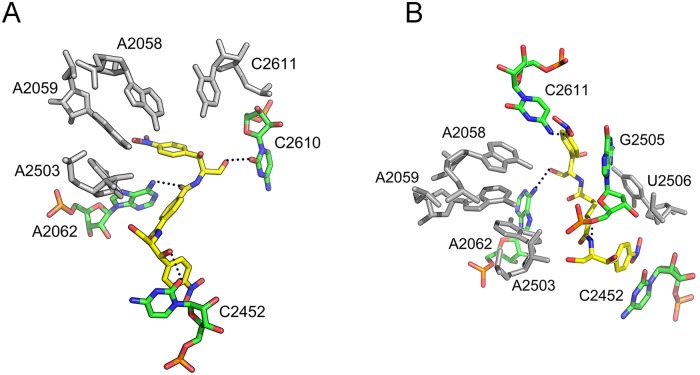
Binding positions of compounds 4 and 5 on the E. coli ribosome, as detected by Molecular Dynamics simulations.Compounds 4 and 5 have been docked into the 50S ribosomal subunit, by positioning one of their CAM moieties within the CAM crystallographic pocket [4]. (A) Binding position of compound 5 (yellow); hydrogen bonding with residues of the catalytic center is shown by black dots. Other residues of 23S rRNA placed adjacently to the binding pocket of 5 are ignored for clarity. (B) Binding position of compound 4 (yellow).